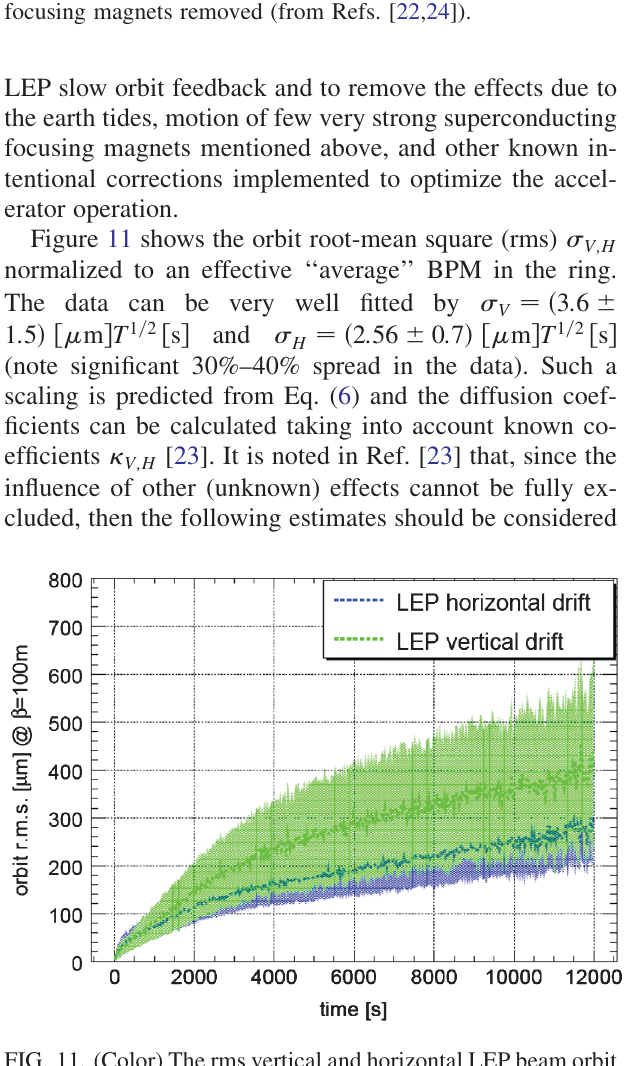
FIG. 11. (Color) The rms vertical and horizontal LEP beam orbit drifts during 1999 operation. The (cid:9) / T 1 = 2 growth with time interval T is visible (from Ref. [23]).